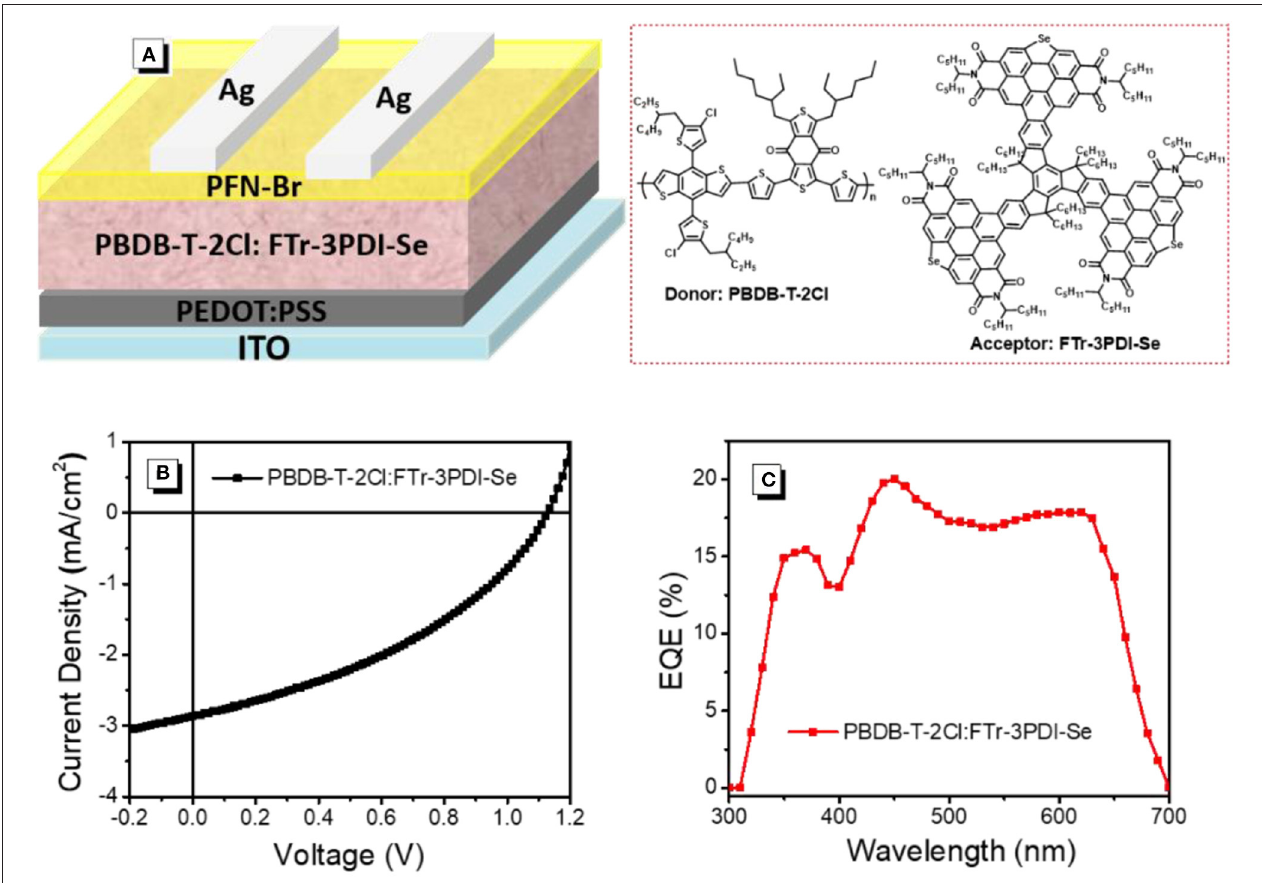
FIGURE 3 | (A) The device structure; (B) current densityevoltage ( J - V ) characteristics; (C) external quantum efficiency (EQE) spectra of PBDB-T-2Cl: FTr-3PDI-Se solar